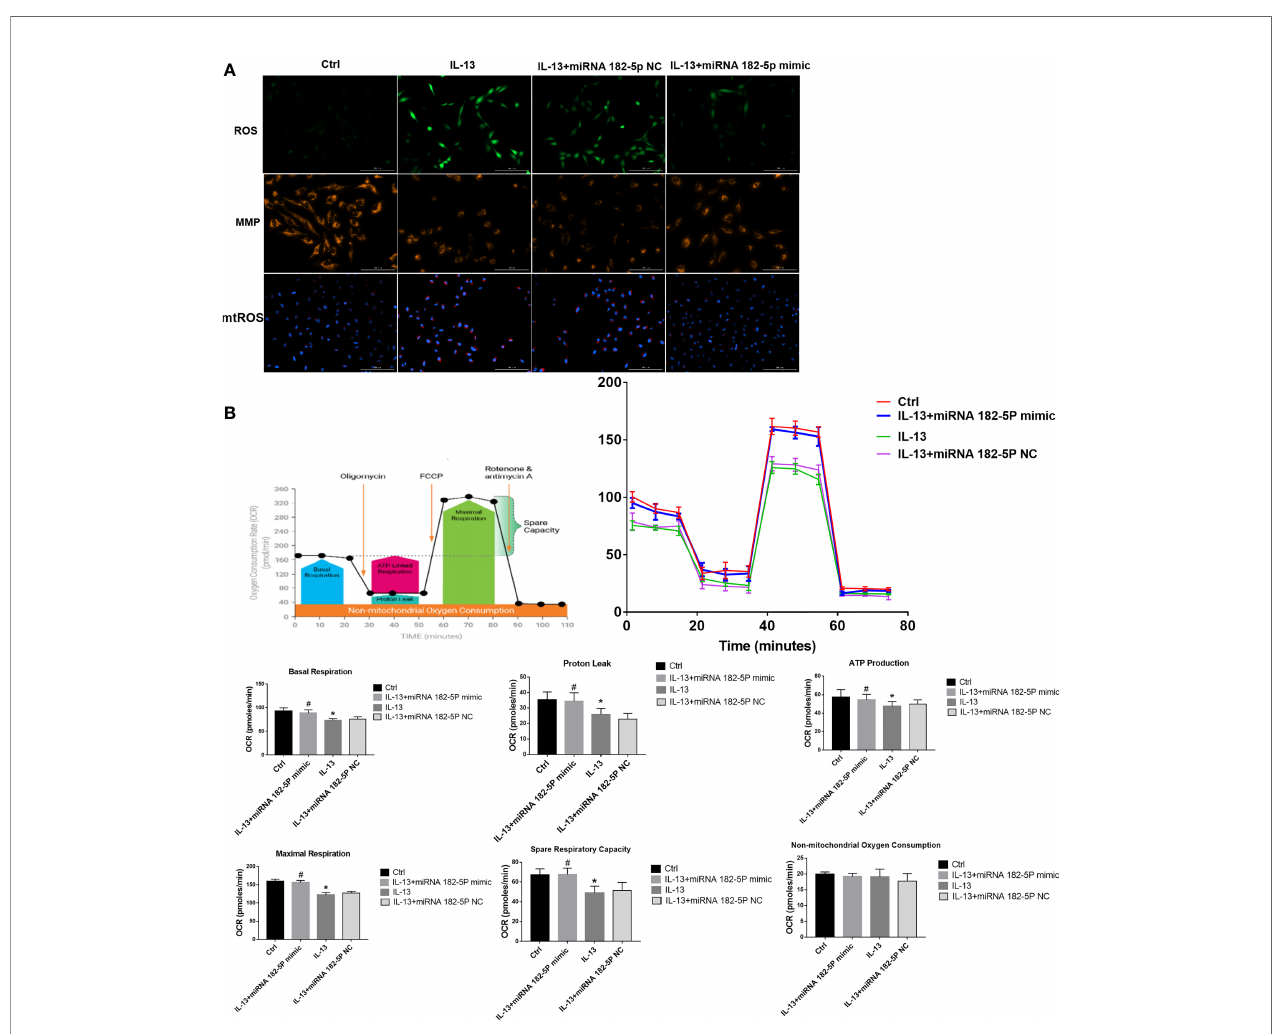
FIGURE 6 | MiRNA-182-5p improves mitochondrial dysfunction. (A) MiRNA-182-5p mimic or NC was used to intervene before IL-13 stimulation of BEAS-2B cells. ROS Assay Kit, tetramethylrhodamine ethyl ester (TMRE) and MitoSOX ™ Red were used to stain BEAS-2B to observe the expression changes of ROS, MMP and mtROS, respectively. Green fl uorescence represented ROS, orange fl uorescence represented MMP and red fl uorescence represented mtROS. Scale bar: 100 µm; (B) MiRNA-182-5p mimic or NC was used to intervene before IL-13 stimulation of BEAS-2B cells. The XFe hippocampal system was performed to determine the expression of proton leak, basal respiration, ATP production, spare respiratory respiration, and maximal perspiration in different groups. All data were shown as mean ± SD (n = 3). # p < 0.05 versus control, * p < 0.05 versus IL-13 group as determined by one-way analysis of variance (ANOVA) and Dunnett ’ s post hoc